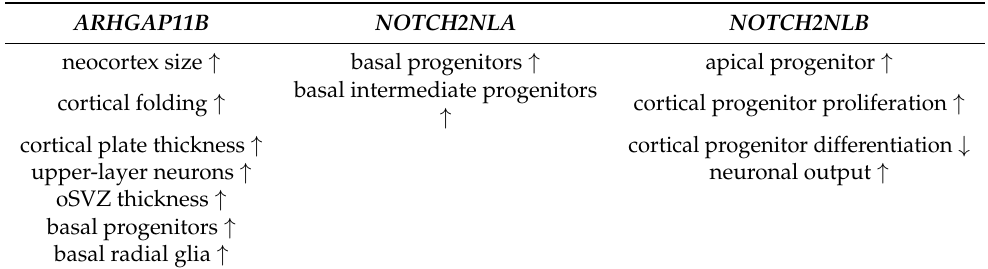
Table 1. Summary of the main functions of ARHGAP11B and of the NOTCH2NL genes during neocortex